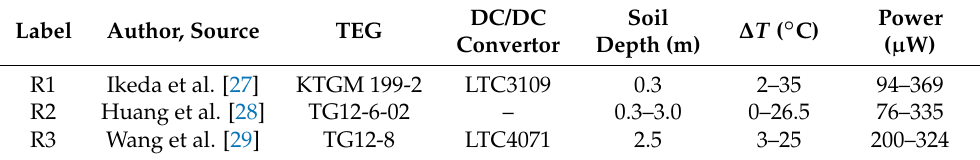
Table 2. Summary of TEG reference